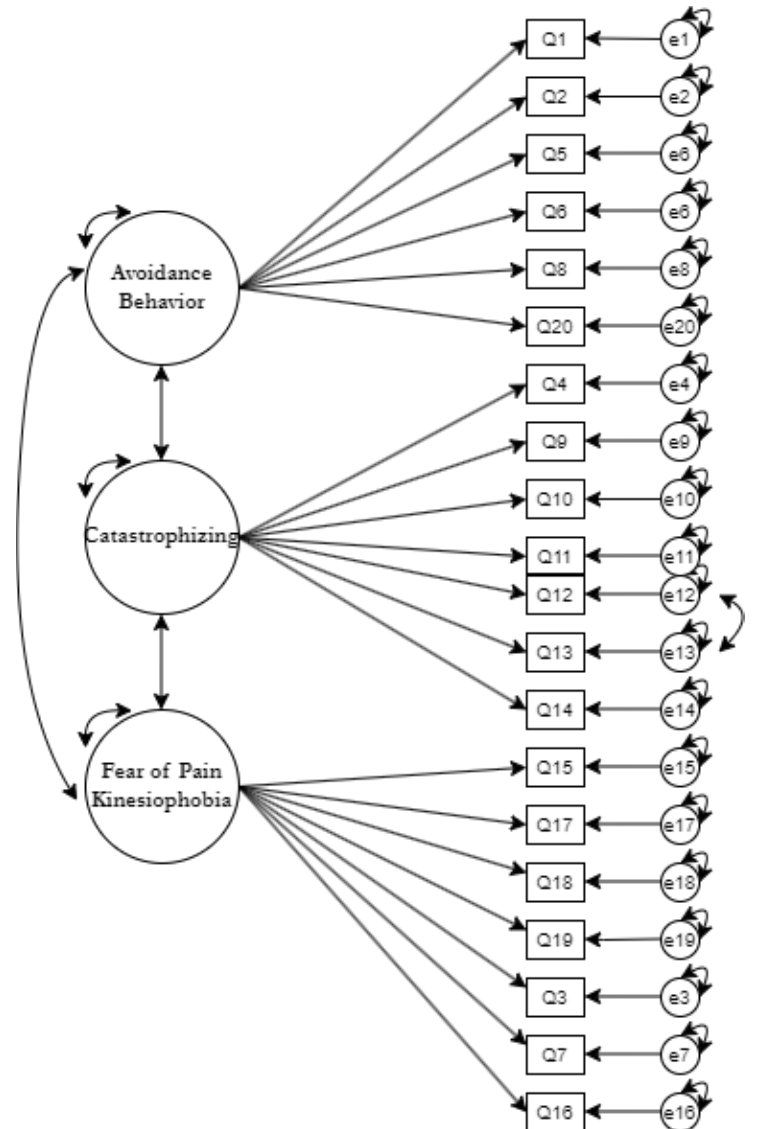
Figure 2. Best Fit Confirmatory Factor Analysis Model: Three-factor model.